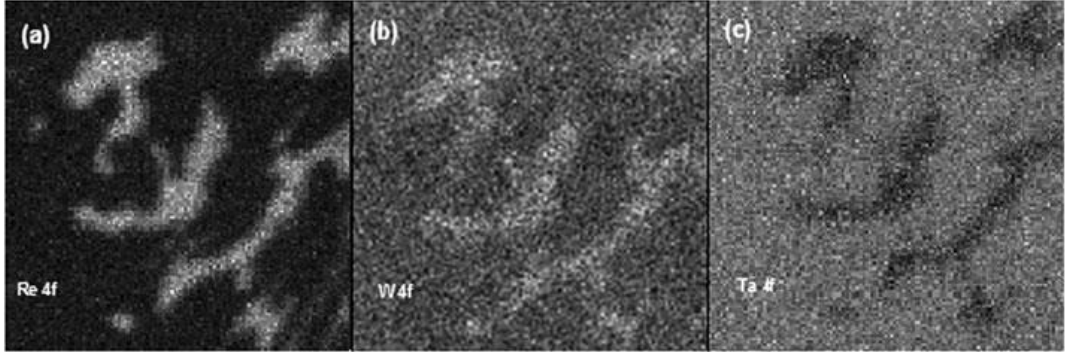
Figure 14. Re 4f ( a ), W 4f ( b ), and Ta 4f ( c ) chemical maps (6.4 × 6.4 µm 2 ) acquired on the interdendritic zone of the as-received sample [26].